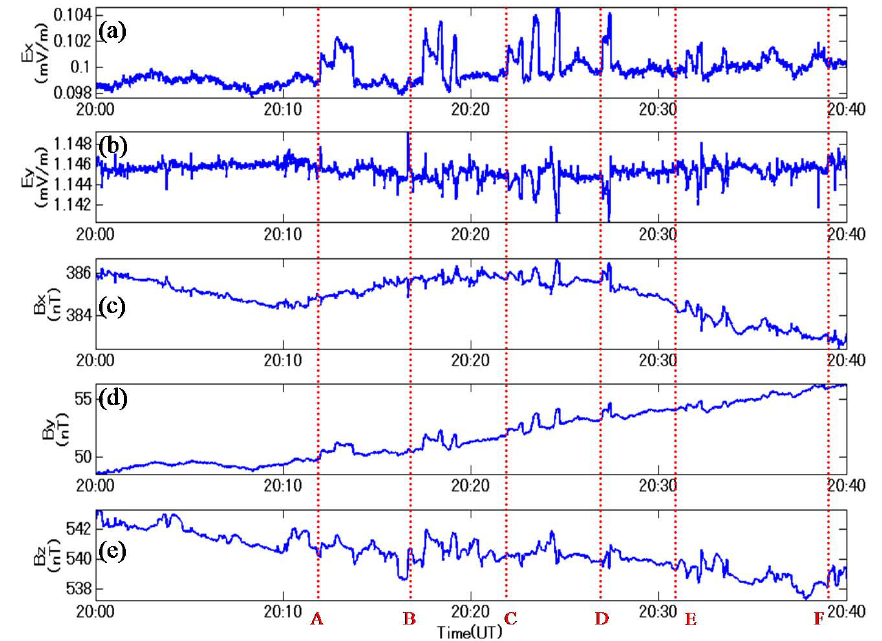
Fig. 14. ULF electromagnetic data when the first train of the day needs to cover the region near the stations. (a) Ex component (mVm − 1 ), (b) Ey component (mVm − 1 ), (c) Bx component (nT), (d) By component (nT), and (e) Bz component (nT). They are observed at KYS station on 1 September 2002.